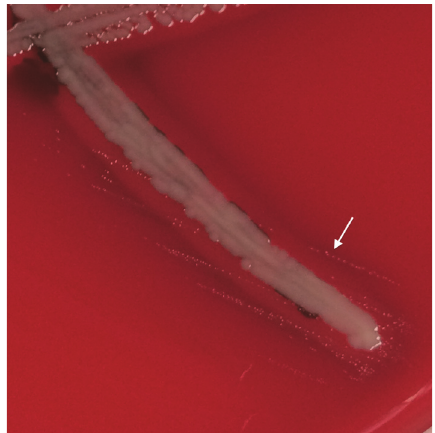
Figure 2: Satellite growth of nutritional variant streptococci (NVS) around Staphylococcus aureus . Small colonies of NVS are seen in areas on the blood agar plate where S. aureus has completely lysed red blood cells ( 𝛽 -hemolysis), releasing nutrients required for NVS